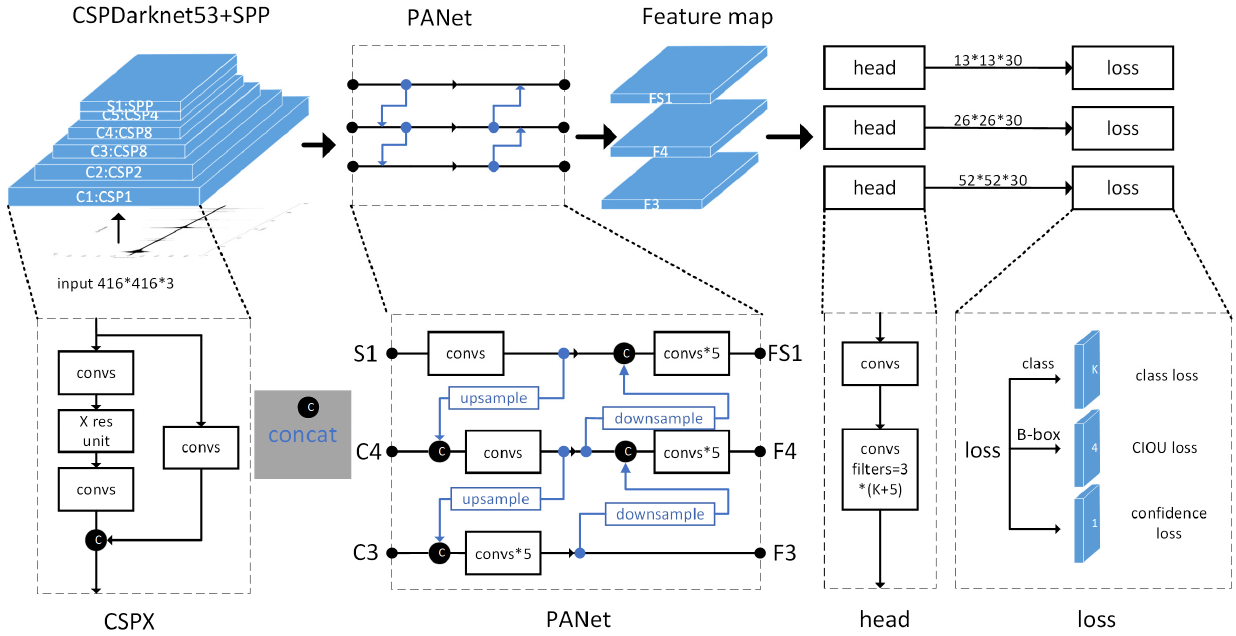
Figure 7. Flowchart of the network structure of YOLOv4.